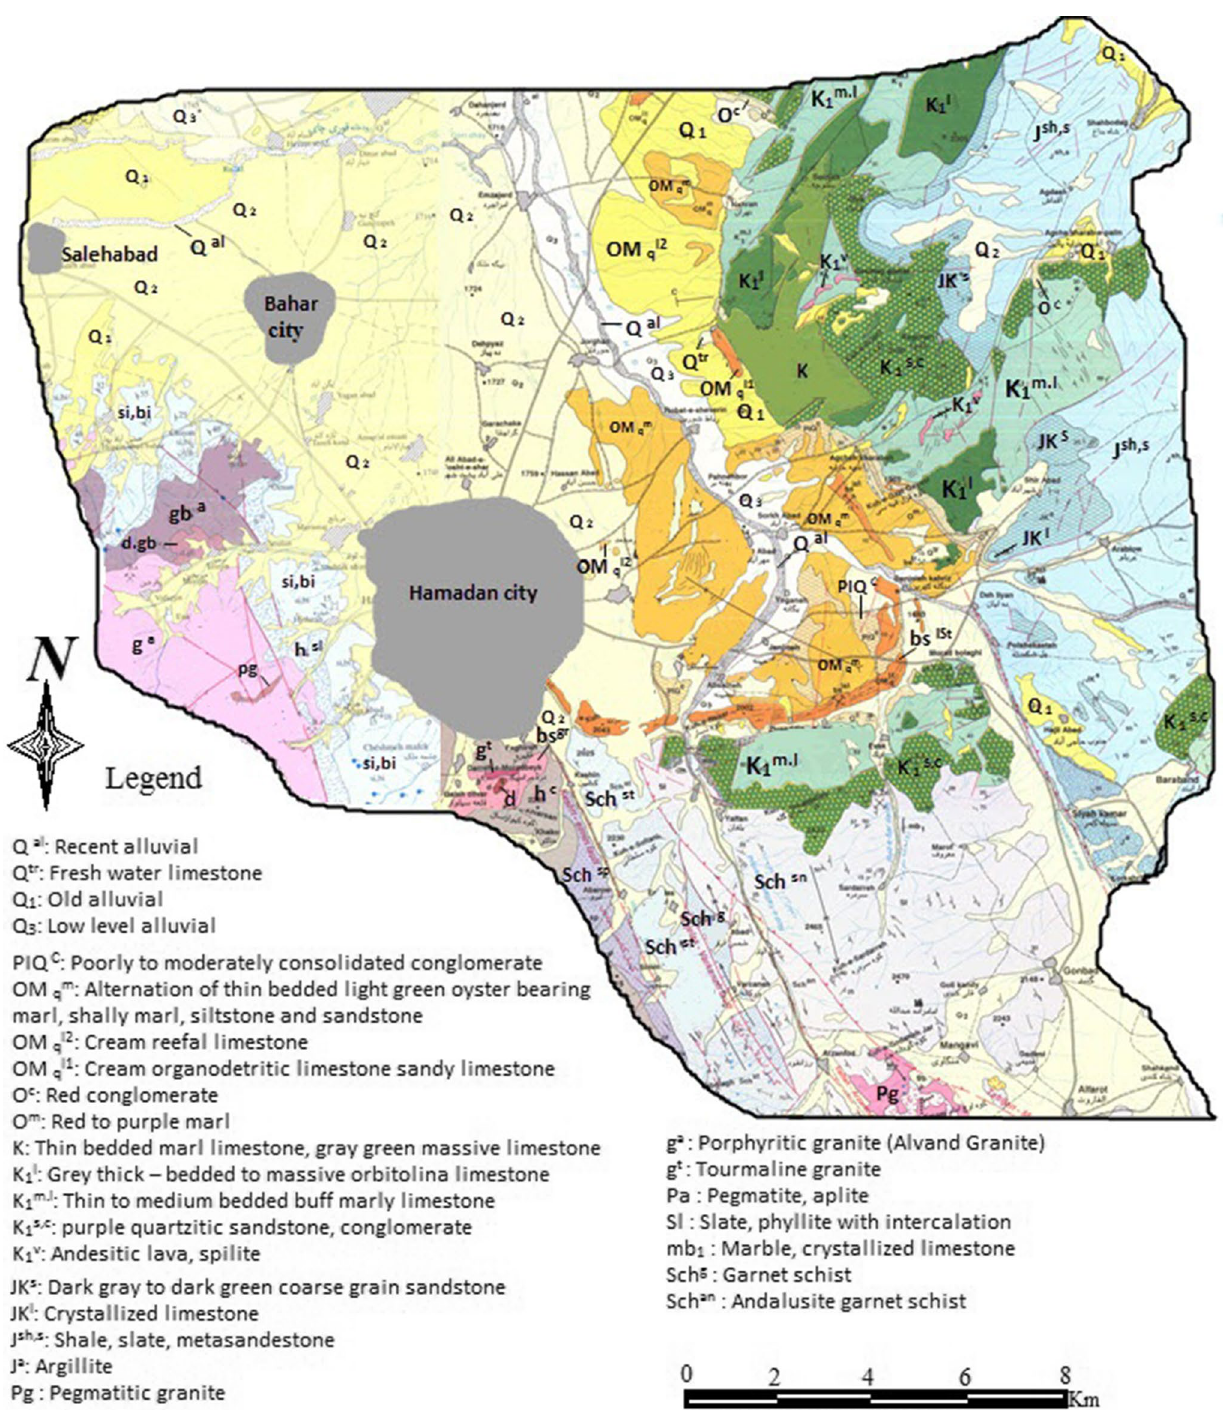
Fig. 2 Geological map of study